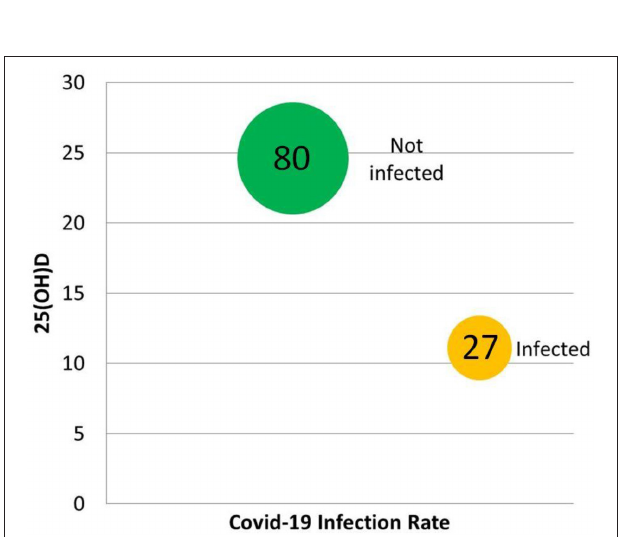
FIGURE 7 | Some of the results of the retrospective chart review by Lau et al. ( 157). In the 20 hospitalized individuals tested for both 25(OH)D and COVID-19, vitamin D predicted severity of